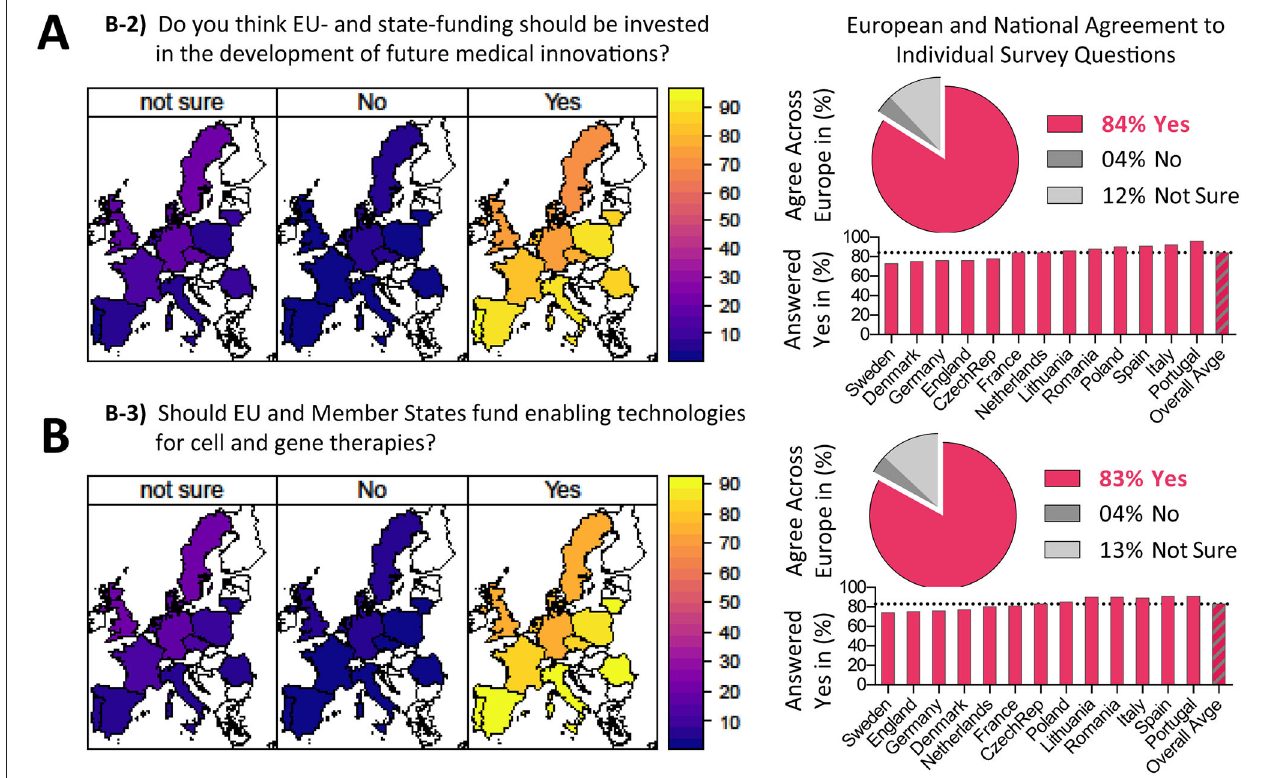
FIGURE 3 | Opinions on public funding in healthcare. (A,B) Results on survey topic B sorted according to questions B2-B3 (Question B1 is show separately as introductory topic in Figure 1 ) with geographical heatmaps shown to the left and corresponding numerical depiction shown to the right, with pie charts displaying the (%) agreement across Europe and bar charts displaying (%) answered yes per country. Interestingly, an overwhelming 84% of European citizens agree that EU- and state-funding should be invested in the development of future medical innovations, while 83% agree that EU and member states should fund enabling technologies for cell and gene therapies, with only 4% of EU citizens answering ‘No’ and 12-13% answering ‘Not Sure’, indicating a strong support of EU citizens for funding future medical innovations and enabling technologies for cell and gene